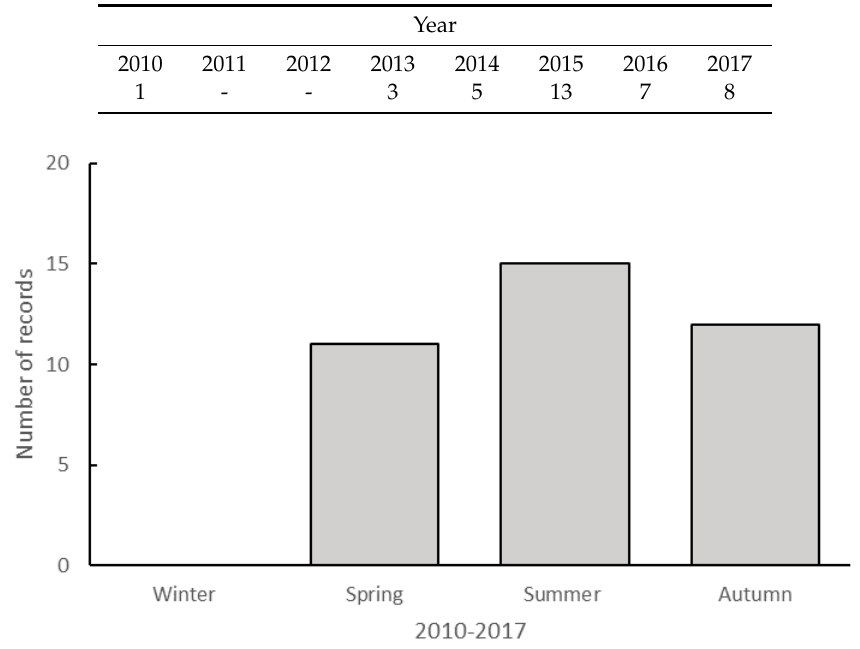
Figure 4. Number of published observations that represent range extension records by season (austral) from 2010 to 2017 ( n = 37).